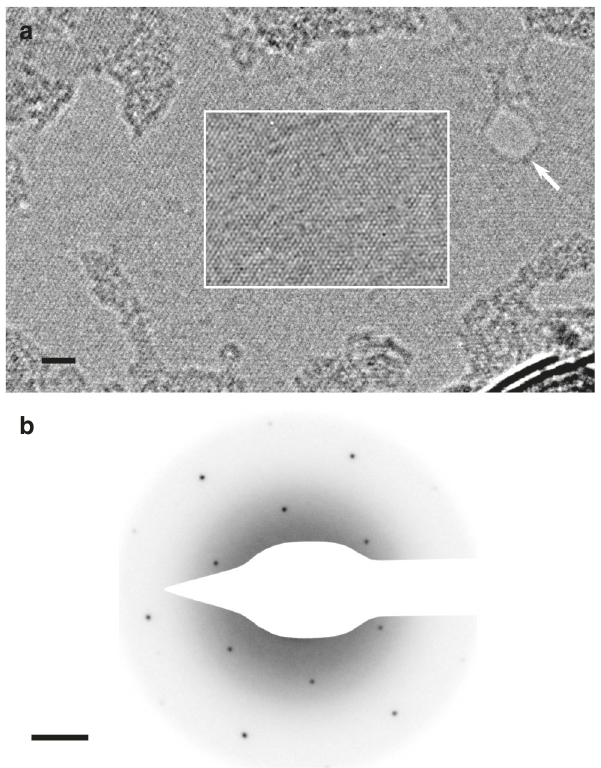
Fig. 3 TEM characterisation of MoS 2 . a High-resolution TEM of suspended MoS 2 . A hole in the monolayer introduced by knock-on damage during imaging is indicated (white arrow), where lattice fringes are absent. The boxed region has had an iterative nonlinear denoising fi lter applied to highlight the MoS 2 lattice and reduce shot noise 50 . Scale bar 2 nm. b SAED pattern of suspended MoS 2 layers with a 100 nm diameter aperture showing single crystal long range order. Scale bar 1 nm −